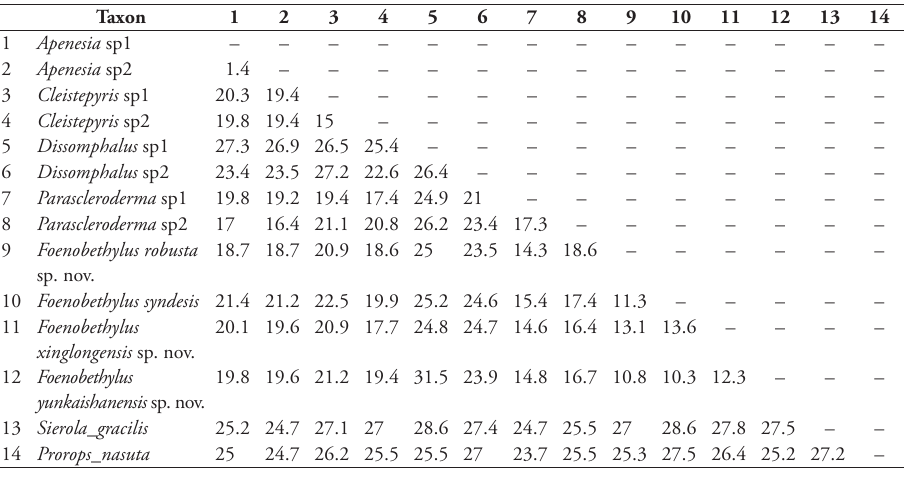
Table 2. Genetic distances of COI sequences among studied taxa (%).